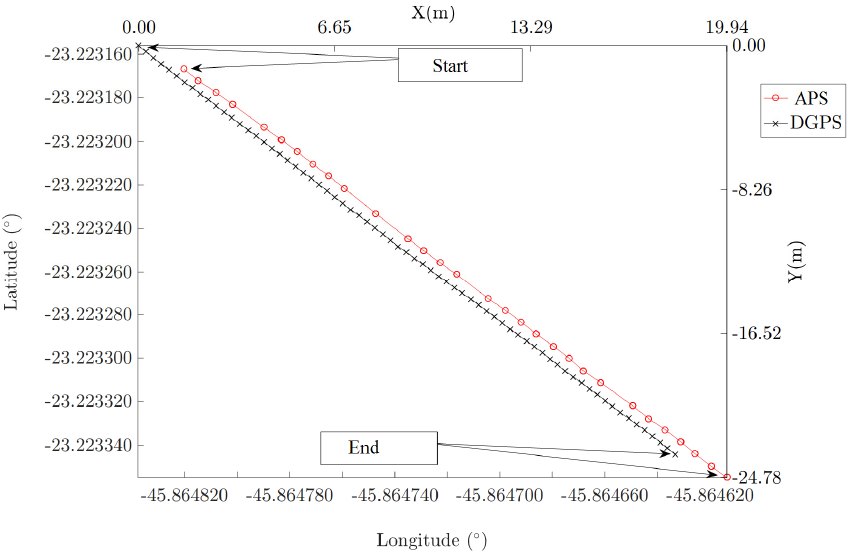
Figure 4. Data points acquired in the dynamic experiment, interval I ‐ 2.2.